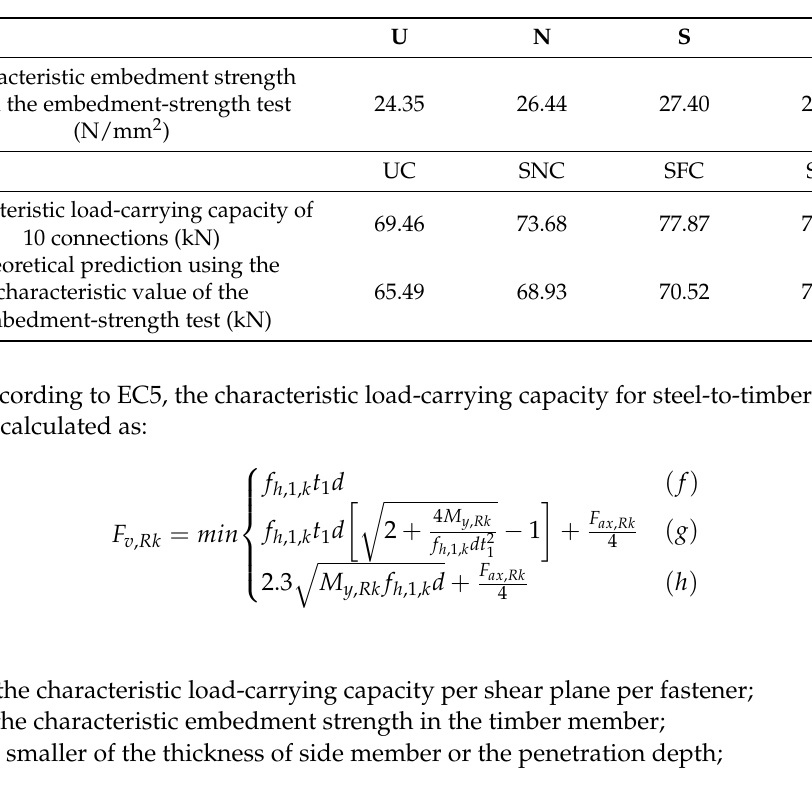
Table 8. Characteristic embedment strength, characteristic load-carrying capacity and theoretical prediction